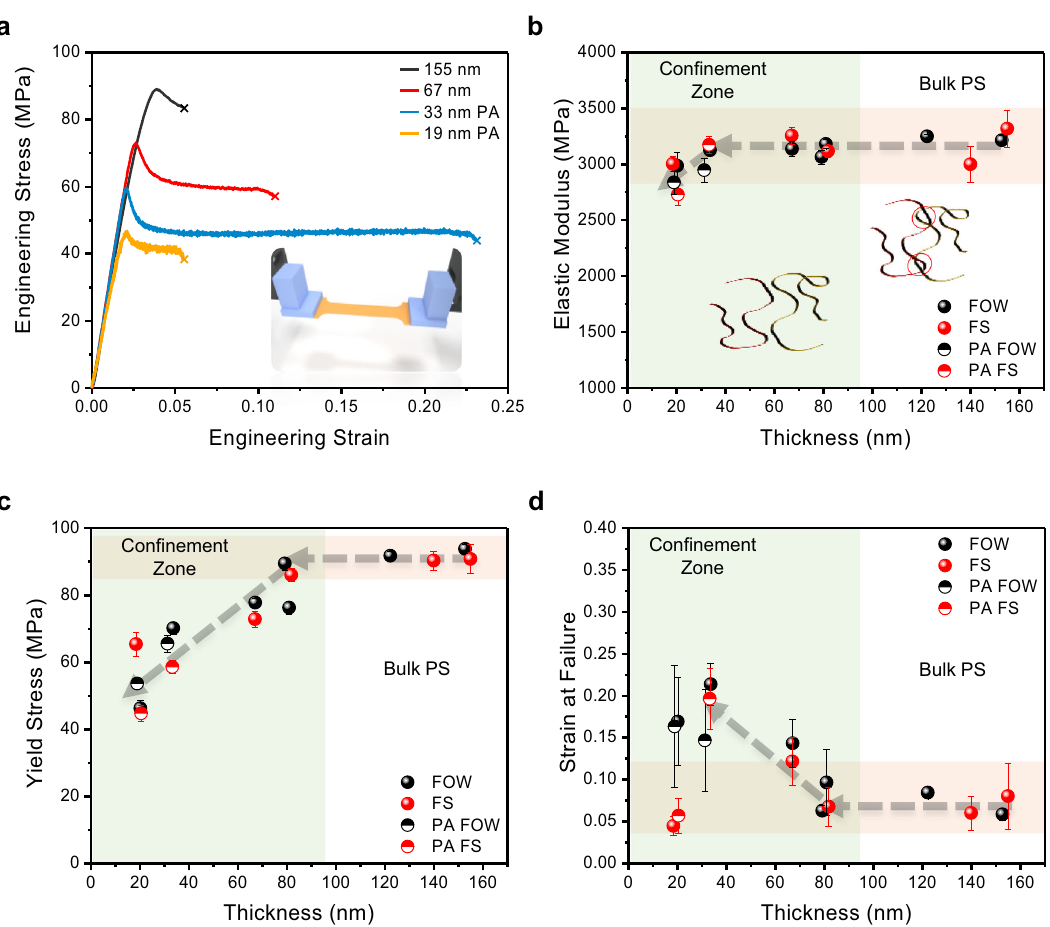
Fig. 2 Comparison of 2062 kDa PS FS and FOW mechanical properties with reducing fi lm thickness. Gauge length is 4 mm. a Representative stress vs. strain pro fi les of FS PS from 155 to 19 nm. b Elastic modulus thickness dependence of both FS and FOW PS fi lms. Insert represents the loss of inter- entanglements upon con fi nement at thicknesses below the end-to-end distance of a polymer chain. c Yield stress thickness dependence of both FS and FOW PS fi lms. d Strain at failure thickness dependence of both FS and FOW PS fi lms. “ PA ” corresponds to samples characterized post vacuum annealing at 115 °C for 1 h. Error bars represent the SD of the characterized mechanical